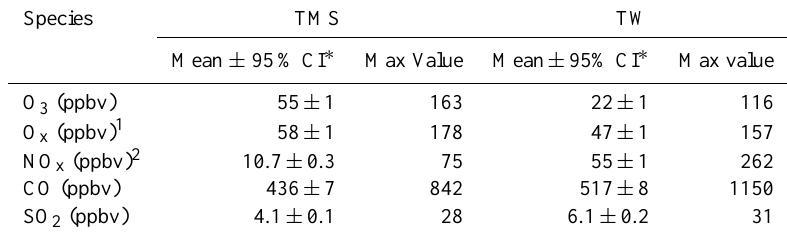
Table 1. Statistics of trace gases at the TMS and TW